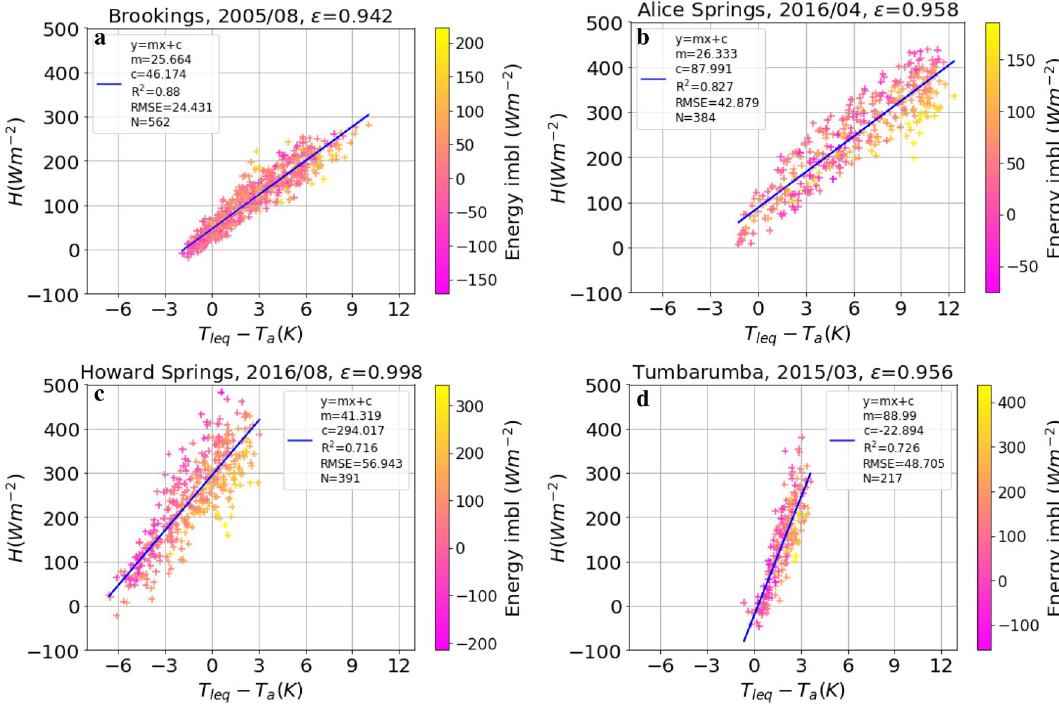
Figure 4. Sensible heat flux as a function of surface-to-air temperature difference based on Eq. (8) ( H = m ( T s − T a ) + c ). ε was fitted to minimise RMSE of a robust linear regression. The title of the plot contains site, year, month and the fitted ε -value. The legend correspond to Fig. 1. The colour code indicates the degree of energy imbalance of each data point (i.e. R net − H − LE − G ). The panels ( a ) to ( d ) refer to the same analysis at different sites, as indicated in the title of each panel.